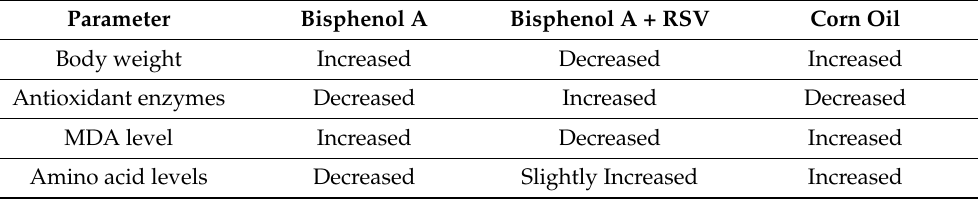
Figure 10. Structure and MS/MS spectrum of L-Carnitine in negative ion mode. Table 3. Comparison of results of different study groups.